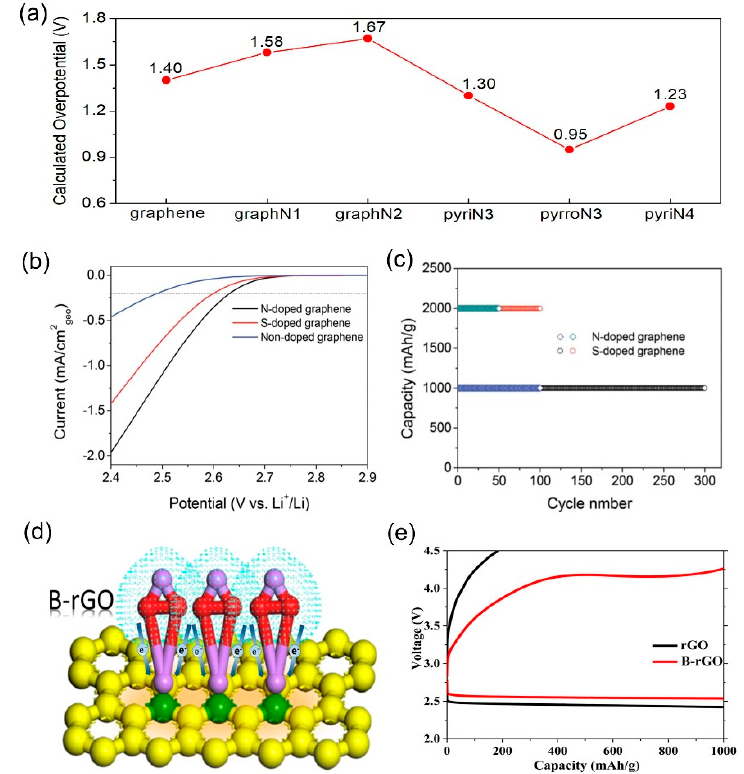
Figure 3. ( a ) The curve of calculated overpotentials (for the initial nucleation of Li 2 O 2 at U = 2.92 V) versus graphene species. GraphN1 and graphN2 represent the graphitic N content of 2.33 wt % and 4.64 wt %, respectively. PyriN3 and pyriN4 represent the pyridinic N content of 7.07 wt % and 9.59 wt %, respectively. PyrroN3 represents the pyrrolic N content of 7.07 wt %. ( b ) Background-corrected ORR polarization curves of pristine, S-doped, and N-doped graphene electrodes collected in O 2 -saturated 1.0 M LiTFSI / TEGDME at 50 mV · s − 1 . ( c ) Cycling performance of S-doped and N-doped graphene electrodes at the current density of 300 mA · g − 1 in Li-O 2 batteries. ( d ) Schematic illustration of B-rGO as the substrate capturing electrons from Li 2 O 2 . The yellow, green, purple, and red spheres represent C, B, Li, and O atoms, respectively. ( e ) The first discharge-recharge curves of B-rGO and rGO at the current density of 2000 mA · g − 1 in Li-O 2 batteries. ( a ) Data from Ref. [70]. ( b , c ) Reproduced with permission from Ref. [53], copyright 2015, Wiley-VCH. ( d , e ) Reproduced with permission from Ref. [71], copyright 2016, American Chemical Society.